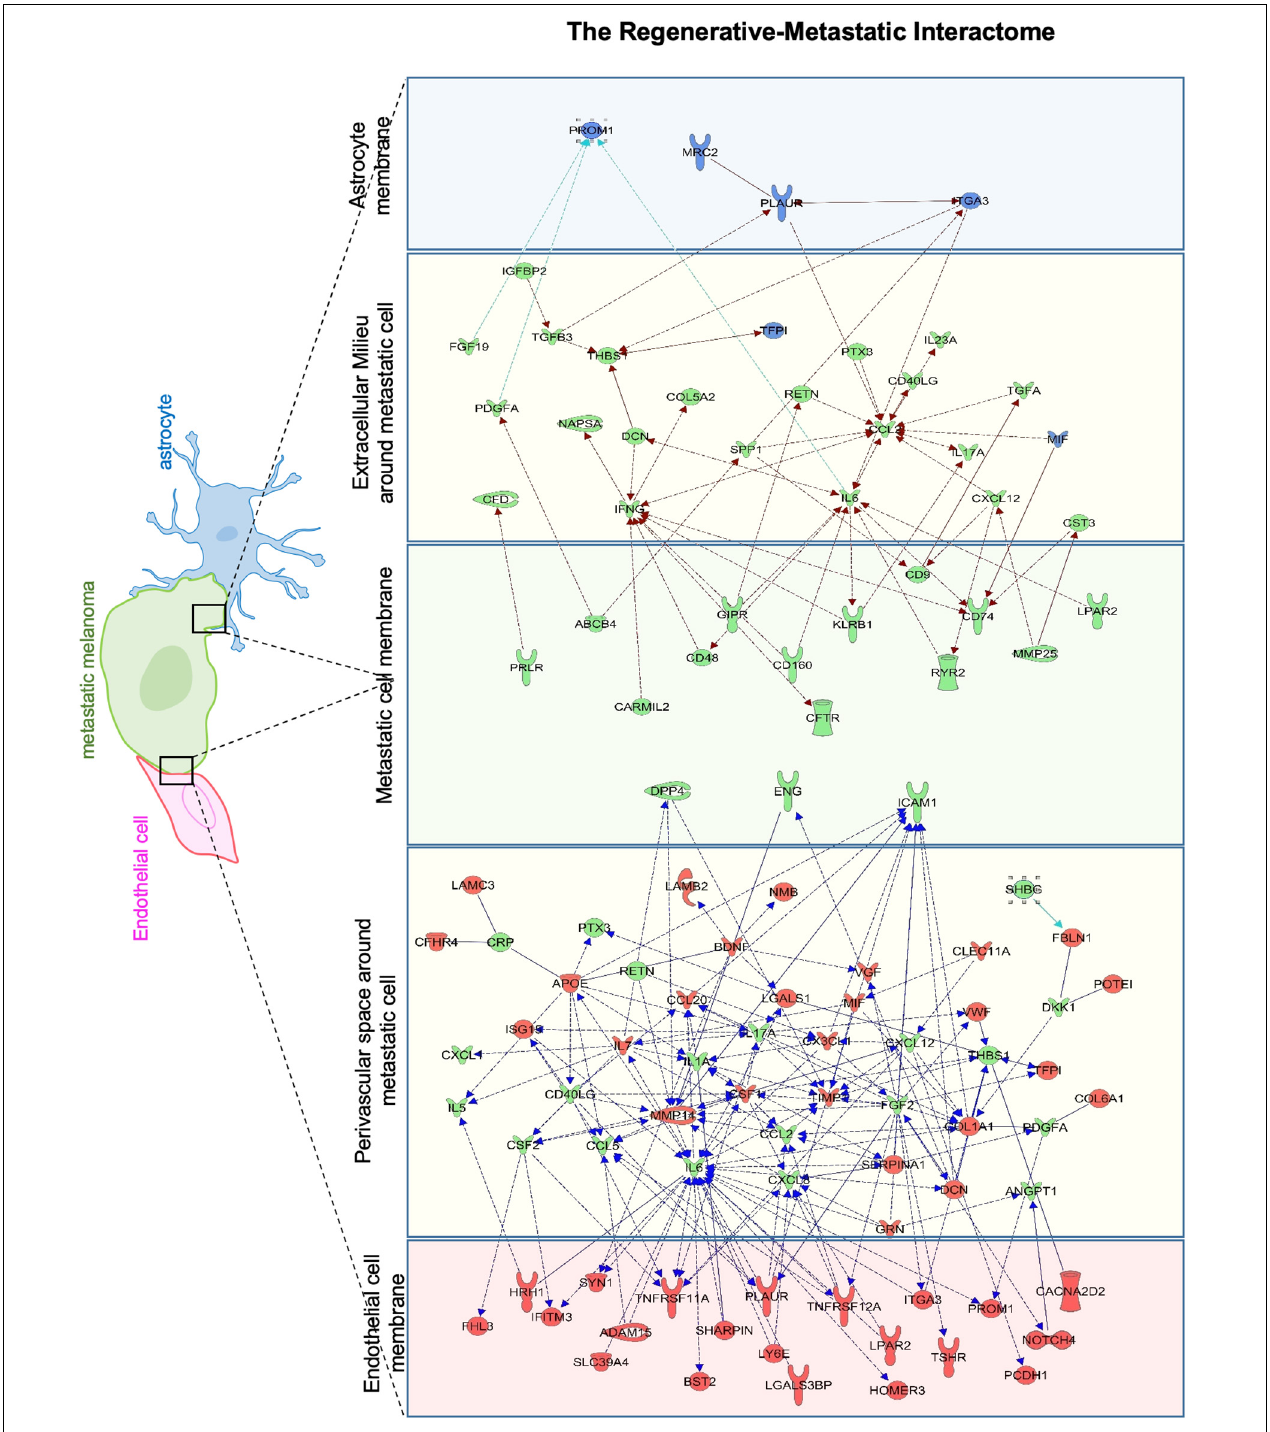
FIGURE 11 | Astrocyte–metastatic cell and endothelial cell–metastatic cell interactome. Extracellular and plasma membrane bound proteins were chosen to determine putative gene interactions between metastatic melanoma cell with two cell types in the regenerative neurovascular niche–astrocyte/endothelial cells. Astrocyte–metastatic cell interactome display differentially expressed proteins in blue shows OGD exposed astrocyte secretome (blue panel) and their interactions with Genes in the metastatic melanoma cells from the Stroke-MET transcriptome colored in green (green panel). Endothelial cell–metastatic cell interactome differentially expressed proteins in red shows OGD exposed astrocyte secretome (red panel) and their interactions with genes in the metastatic melanoma cells from the Stroke-MET transcriptome colored in green (green panel). Yellow panels depicts molecules in the extracellular space. Molecules in yellow: secretome, red: OGD exposed endothelial cells, blue: OGD exposed astrocytes, green: stroke responsive melanoma Stroke-MET.